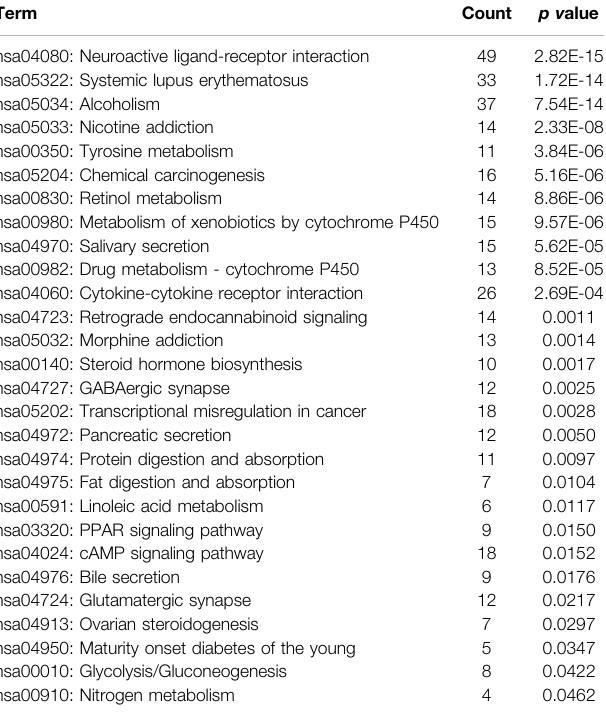
TABLE 1 | KEGG pathways enriched by differentially expressed genes in breast cancer. Term Count